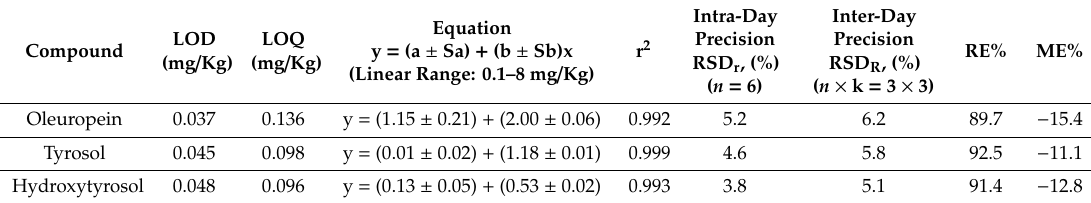
Table 2. Method validation results for